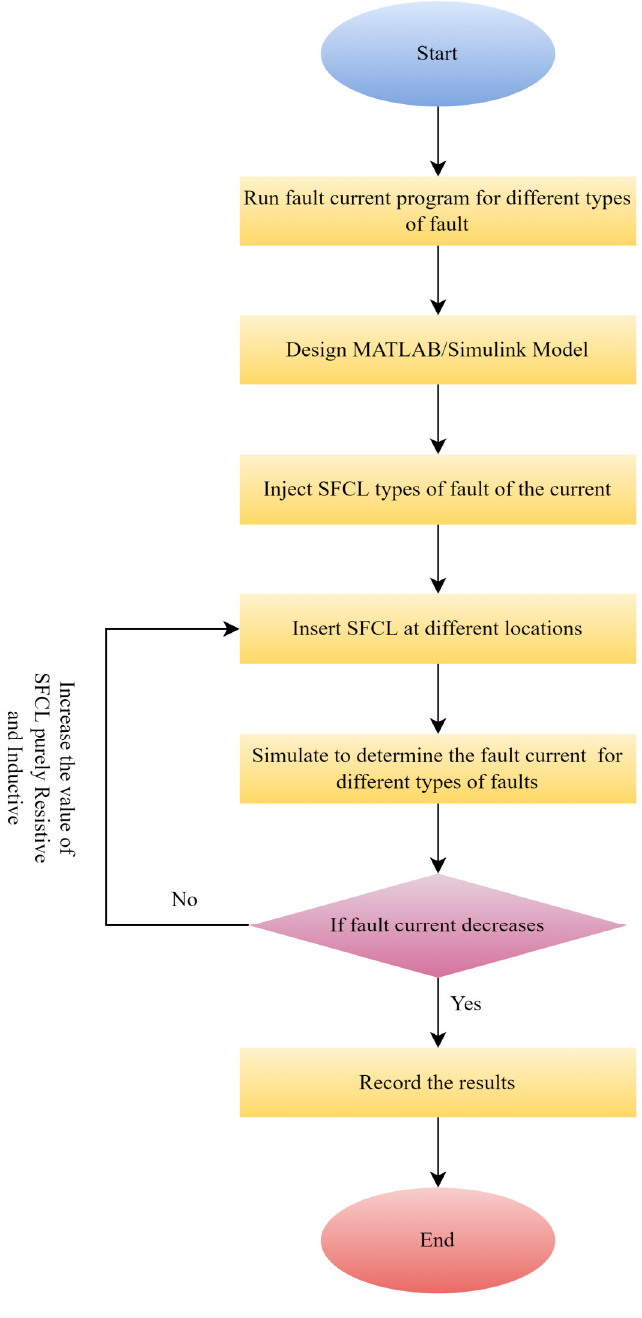
Figure 2. Proposed methodology flow.